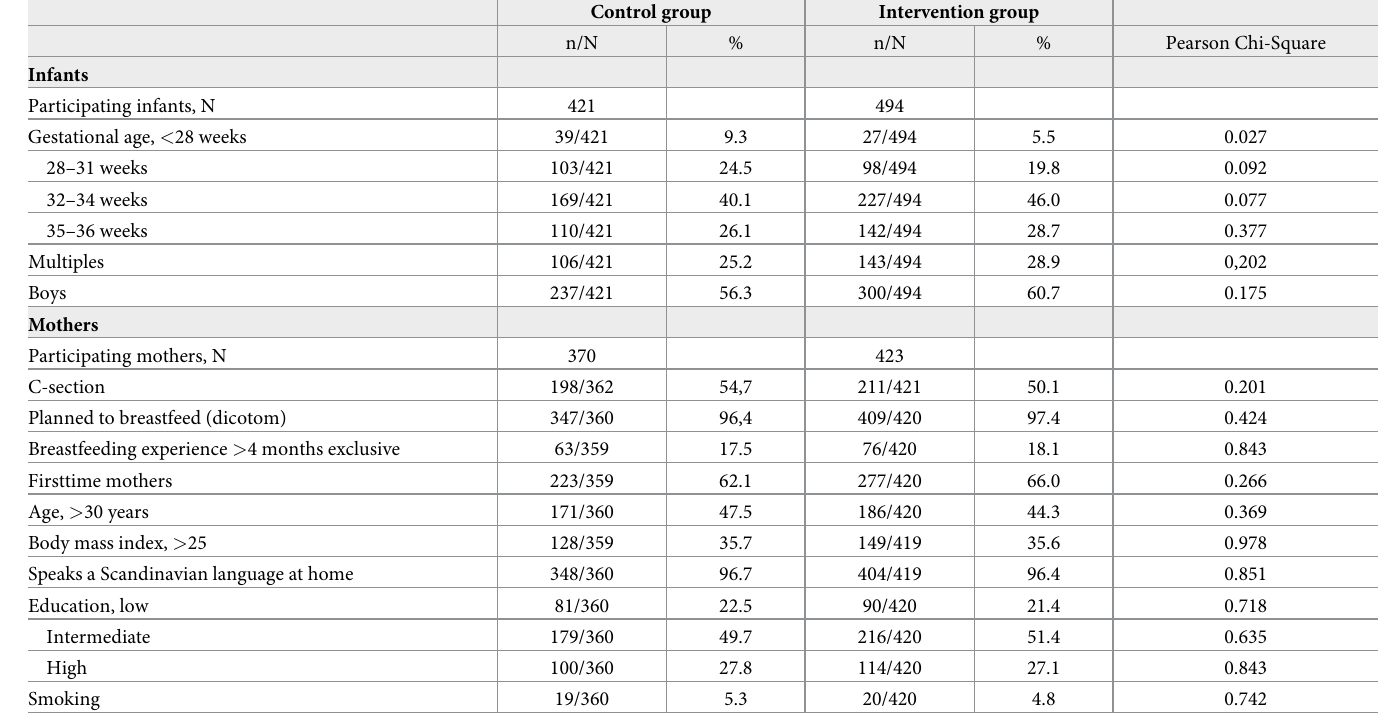
Table 1. Characteristics of participating infants and mothers.